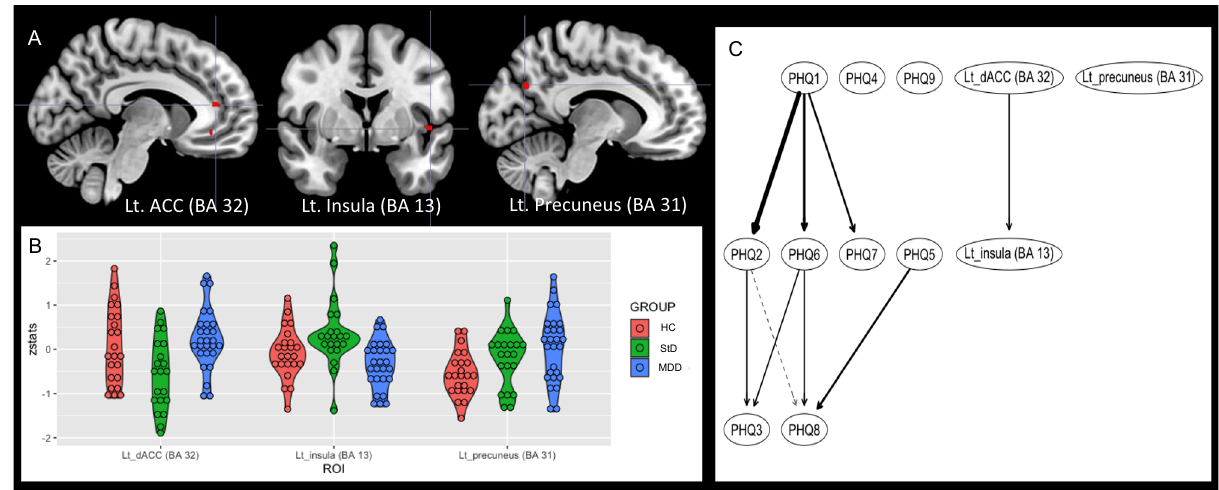
Figure 2. Between-group differences of functional brain activation for conflict control of incongruence trial against larger monetary loss, compared to the congruence trial of target-response location. Conflict control against larger monetary loss was associated with higher functional activation of insula in subthreshold depression (StD) than healthy control (HC) and major depressive disorder (MDD). StD also showed lower functional activation of left dorsal anterior cingulate (dACC) compared to MDD. Higher functional activation of precuneus in MDD compared to HC was also shown. ( A ) Clusters of regional brain functional activation with significant between-group differences (cluster-forming thresholds of P < 0.001 and k ≥ 10). ( B ) Violin plots of z-stats per clusters per group. ( C ) Directed acyclic graph that represents conditional independence associations among depressive symptoms [nine items of Patient-Health Questionnaire-9 (PHQ-9)] and z-stats of 3 brain clusters. PHQ-1 sadness, PHQ2 anhedonia, PHQ3 sleep disturbance, PHQ4 appetite change, PHQ5